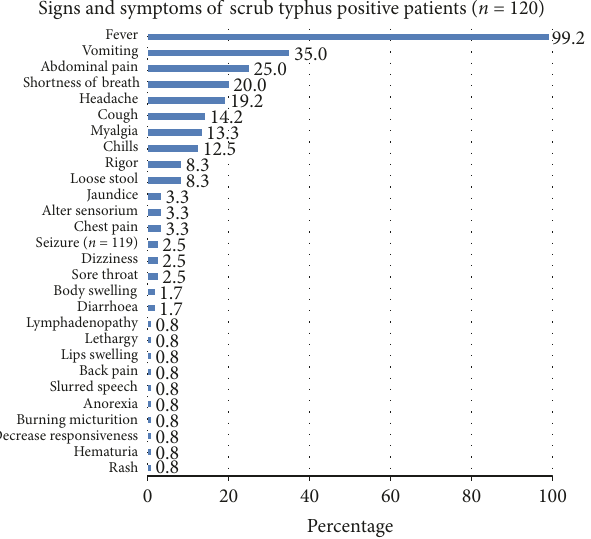
99.2%) had fever. Other chief complaints were vomiting (42, 35%), abdominal pain (30, 25%), shortness of breath (24, 20.0%), and headache (23, 19.2%).